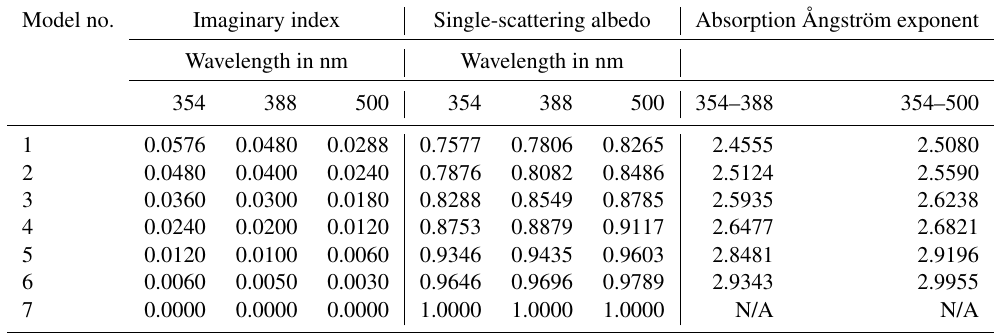
Table A3. Optical and microphysical properties of the OMACA carbonaceous aerosol model. Model no.